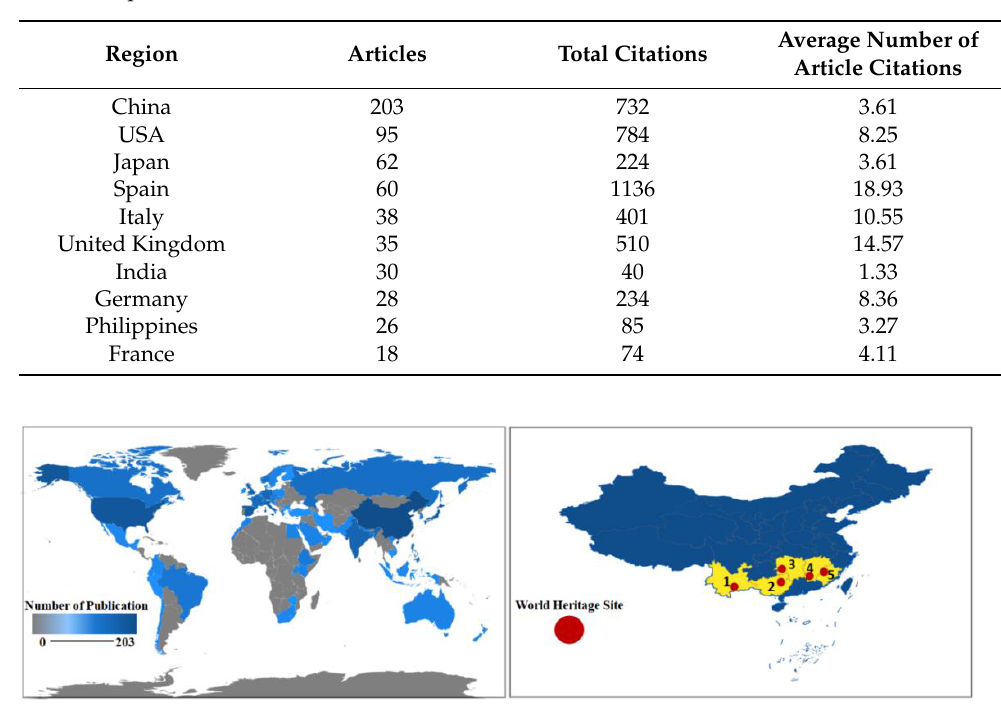
Figure 4. Number of publications on terraced fields in each region of the world.